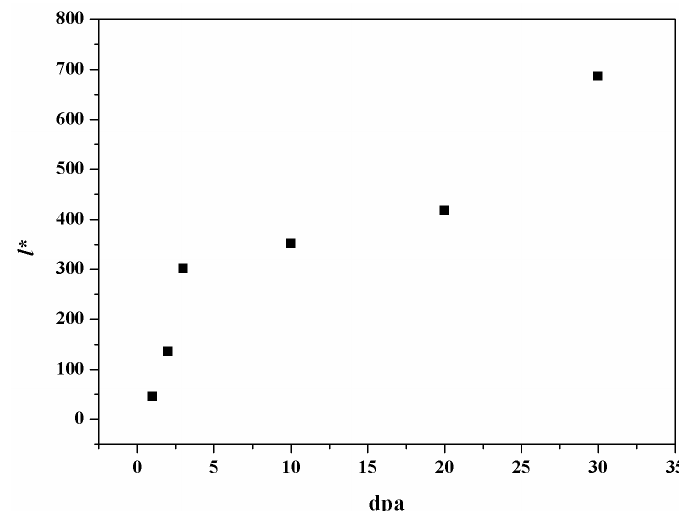
Figure 6. The relationship between the l * and dpa.